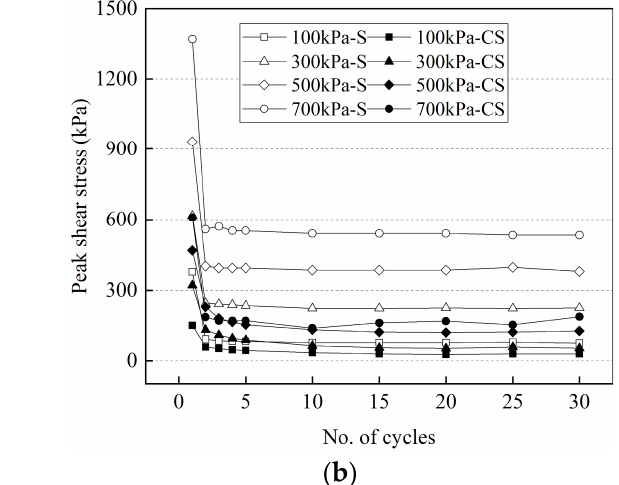
Figure 21. Differences of peak shear stress between frozen cement-treated sand–concrete and frozen sand–concrete interfaces. ( a ) − 2 °C; ( b ) − 14 °C. sand–concrete interfaces. ( a ) − 2 ◦ C; ( b ) − 14 ◦